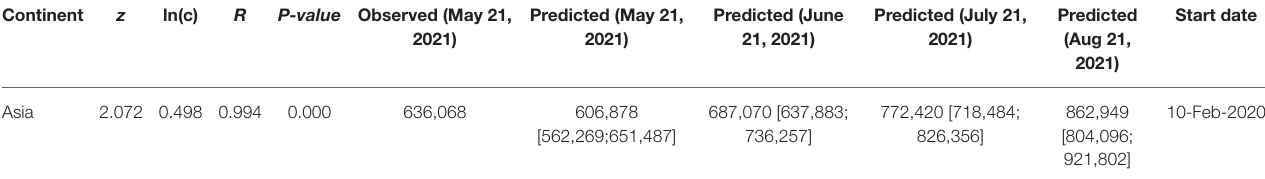
TABLE 2 | The power law for fatality-time relationship (PL-FTR) model fitted for the daily cumulative counts of COVID-19 fatality, augmented with Taylor’s power law (TPL) to obtain the 95% CIs. Continent z ln(c) R P-value Observed (May 21,